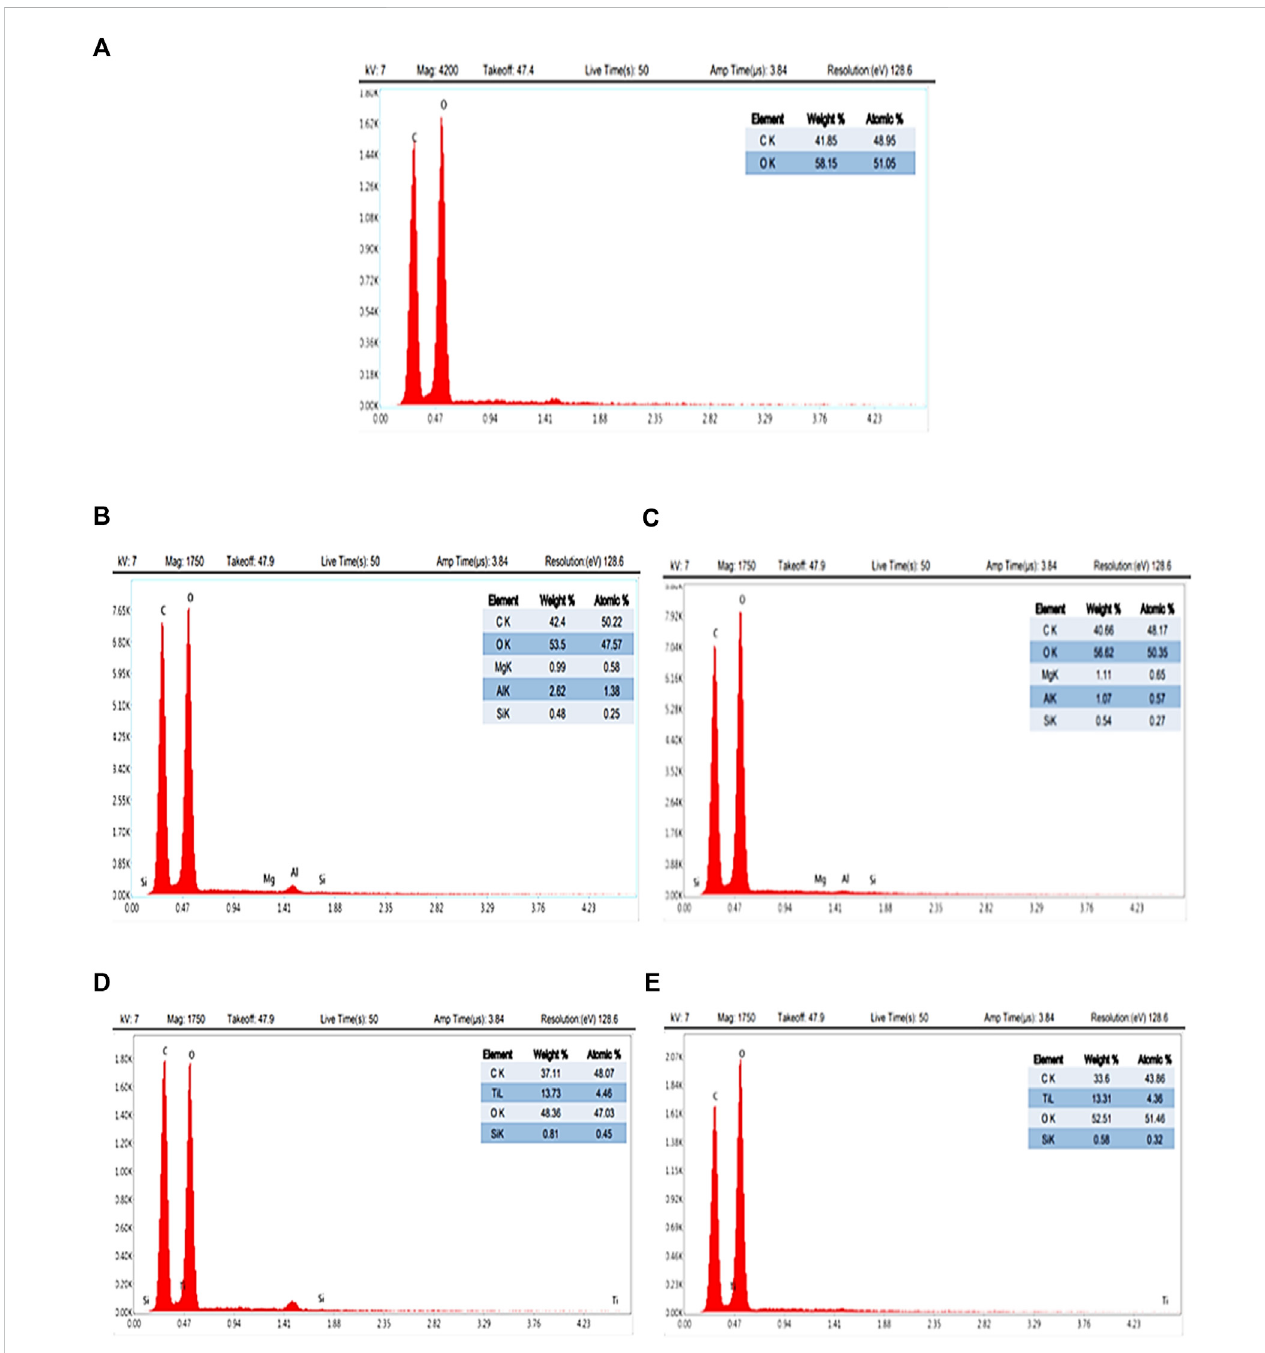
Thesurfacemorphology, porosity, andhomogeneousnessofthedispersed Clay or TiO 2 are necessary to enhance the membrane performance (Golobostanfard and Abdizadeh, 2013; Nivedita and Joseph,